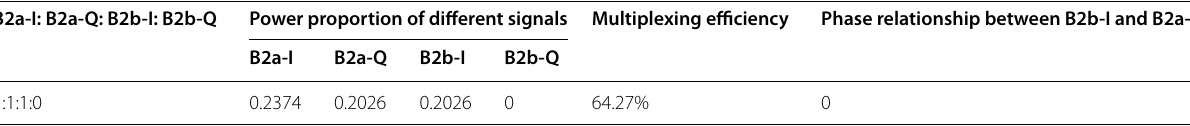
Table 3 Actual power and multiplexing efficiency of each component of Type-III ACE-BOC when the phase relationship between I-components is 0 B2a‑I: B2a‑Q: B2b‑I: